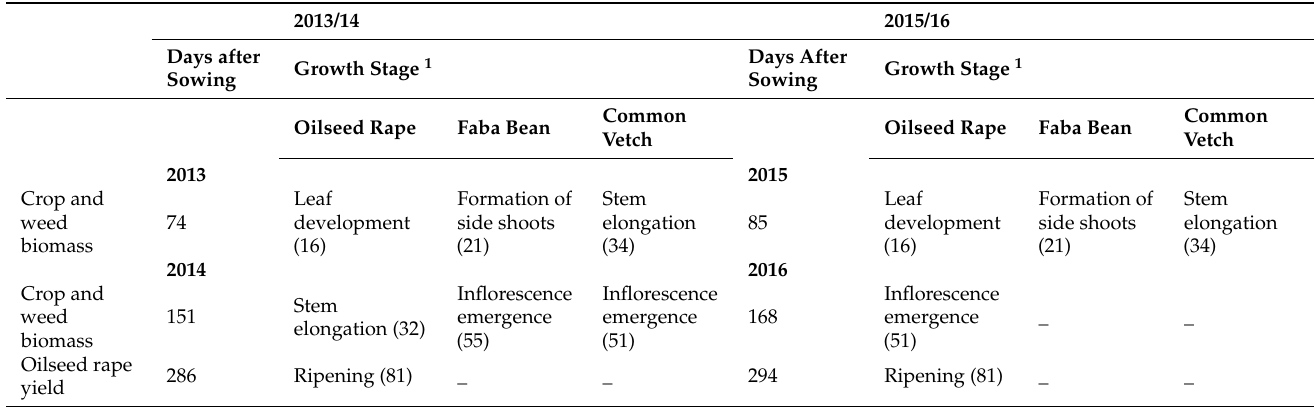
Table 2. Dates of weed and crop biomass samplings with the corresponding days after sowing and crop growth stages (BBCH) in 2013/14 and